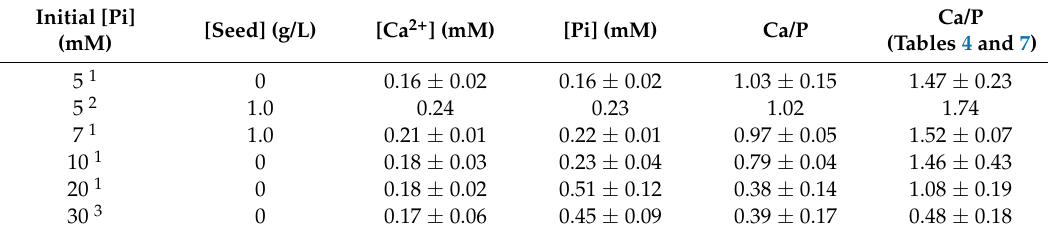
Table 10. Measured dissolved [Ca 2+ ], [Pi], and Ca/P in distilled and deionized water compared with Ca/P values predicted from the change in precipitating solution